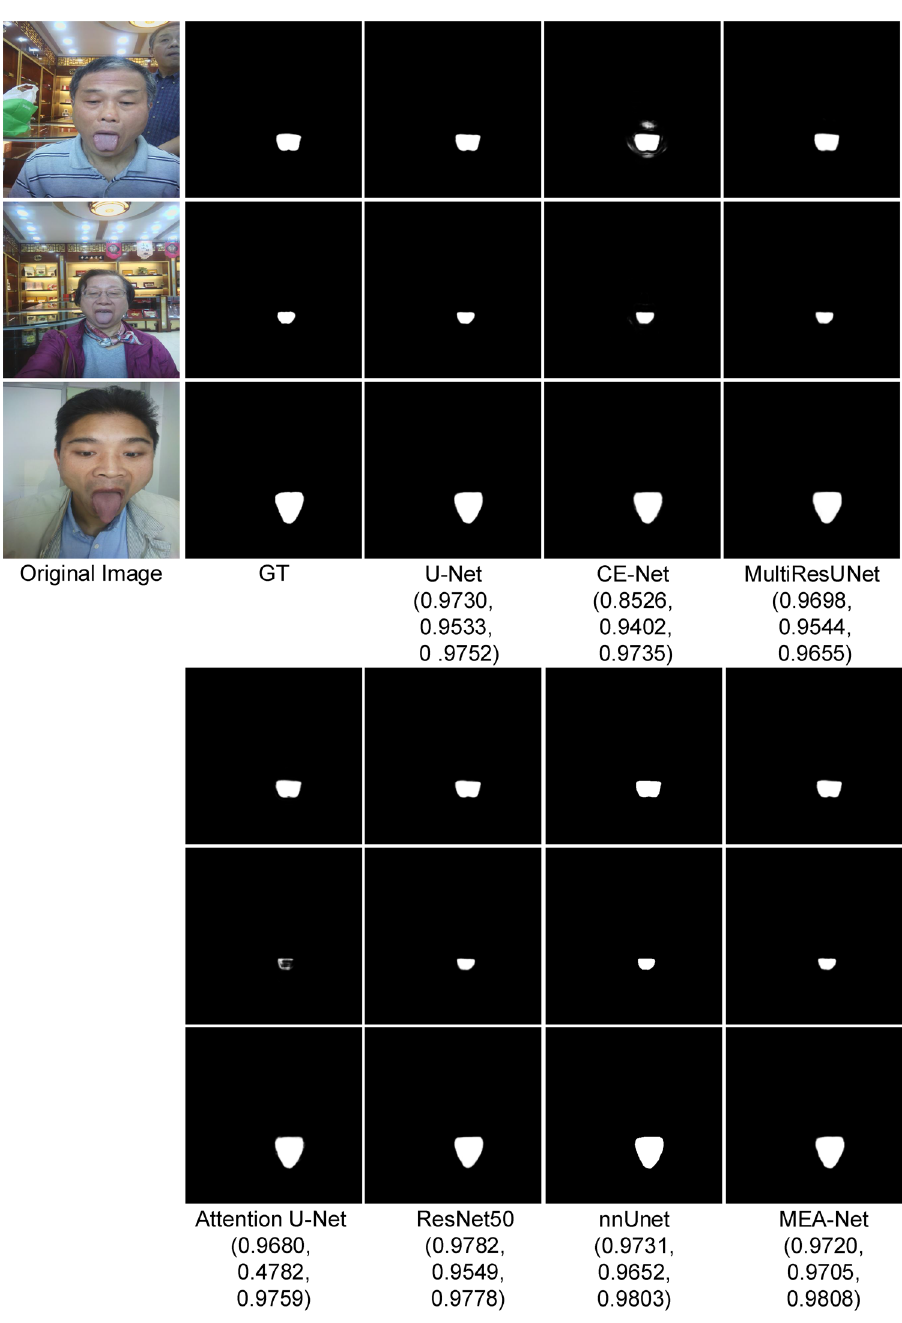
better than that of the proposed baseline. Next, we tested the EFE module with E1 and E2 (MEA-Net (E1 + E2)). The comparison results showed that our MEA-Net reached better results in four datasets. It can be observed that